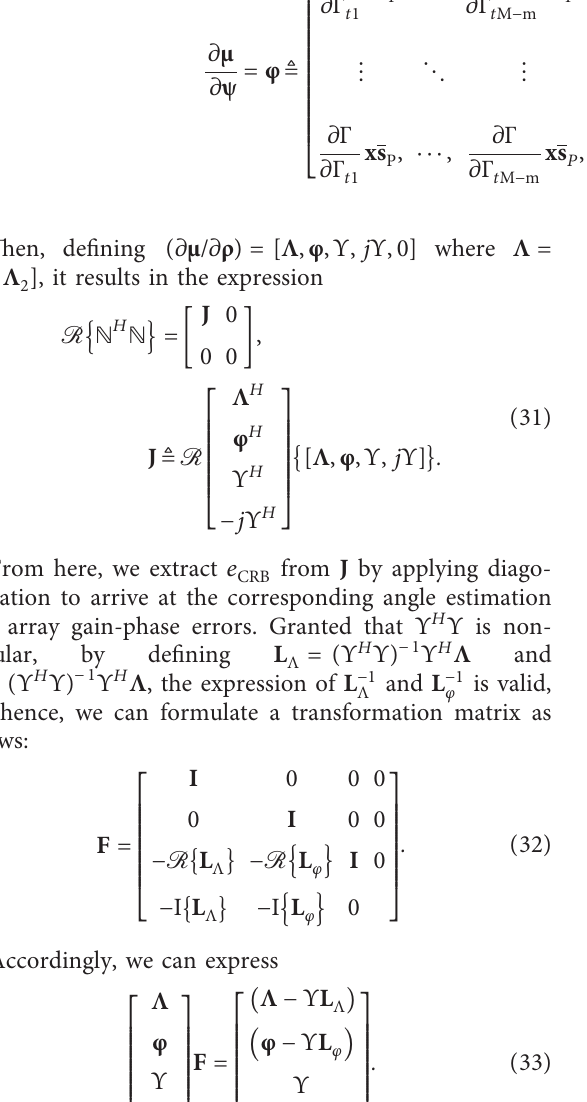
Algorithm 1 only needs O ( MNPG + ( MN ) 2 G )